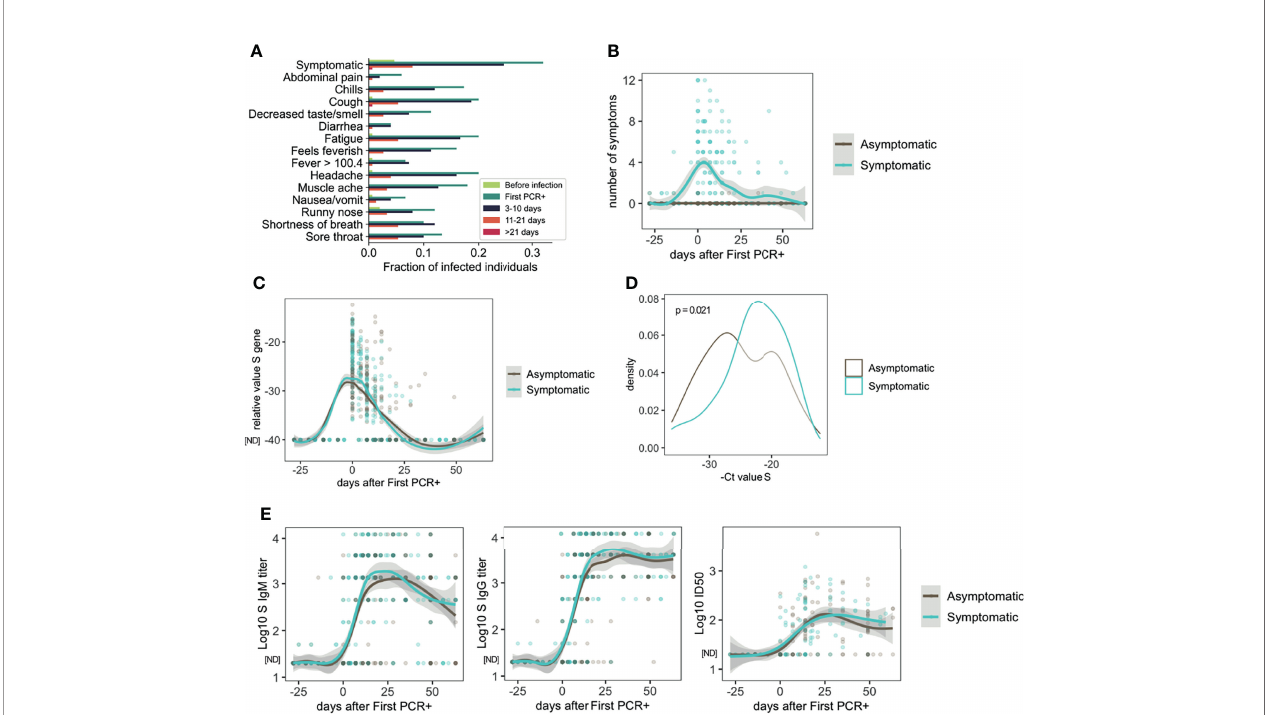
FIGURE 1 | Symptoms, viral load and antibody response in asymptomatic and mild symptomatic participants (n=85 asymptomatic and n=64 symptomatic). (A) Distribution of symptoms and fever reported over time. (B) Number of symptoms over time. (C) Longitudinal distribution of viral load as measured by PCR (S Ct values). (D) S gene PCR results at fi rst SARS-CoV-2 positive test in asymptomatic and symptomatic participants. (E) Longitudinal analysis of serum IgM and IgG S- speci fi c titers (n=85 asymptomatic and n=64 symptomatic participants), and half inhibitory infectious dose (ID50), (n=45 asymptomatic and n=46 symptomatic participants). ND, Not